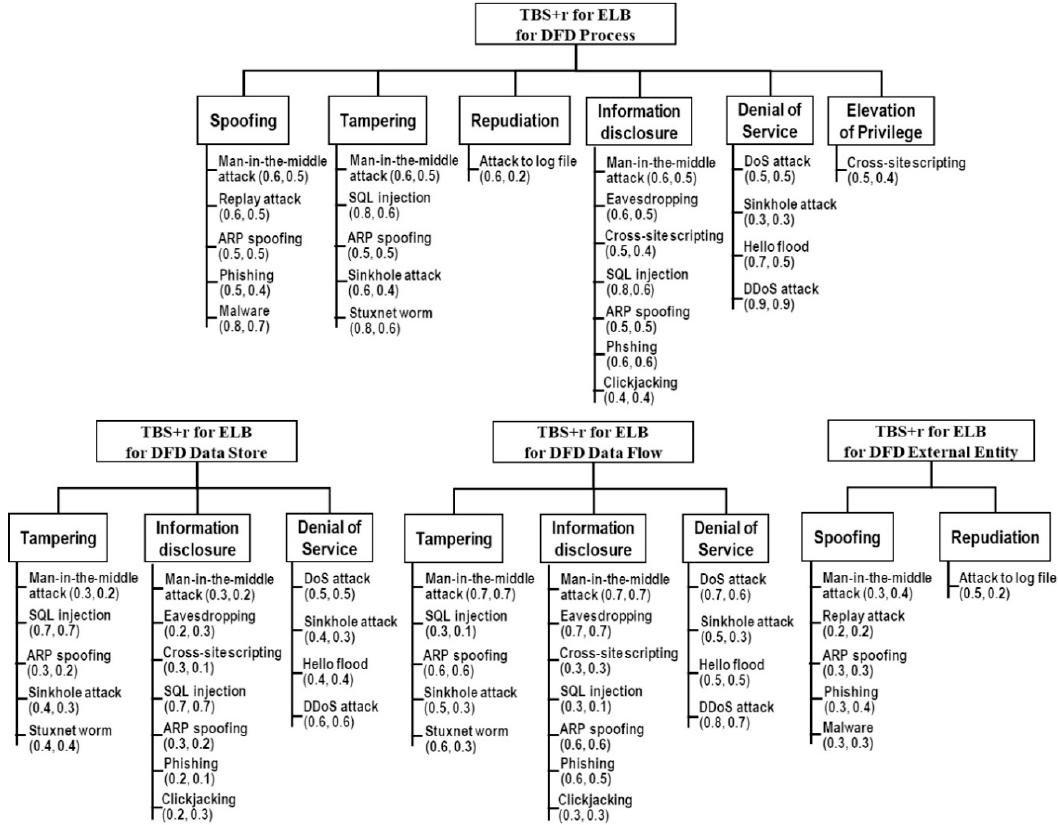
Figure 10. The adopted TBS+r for the ELB practice.